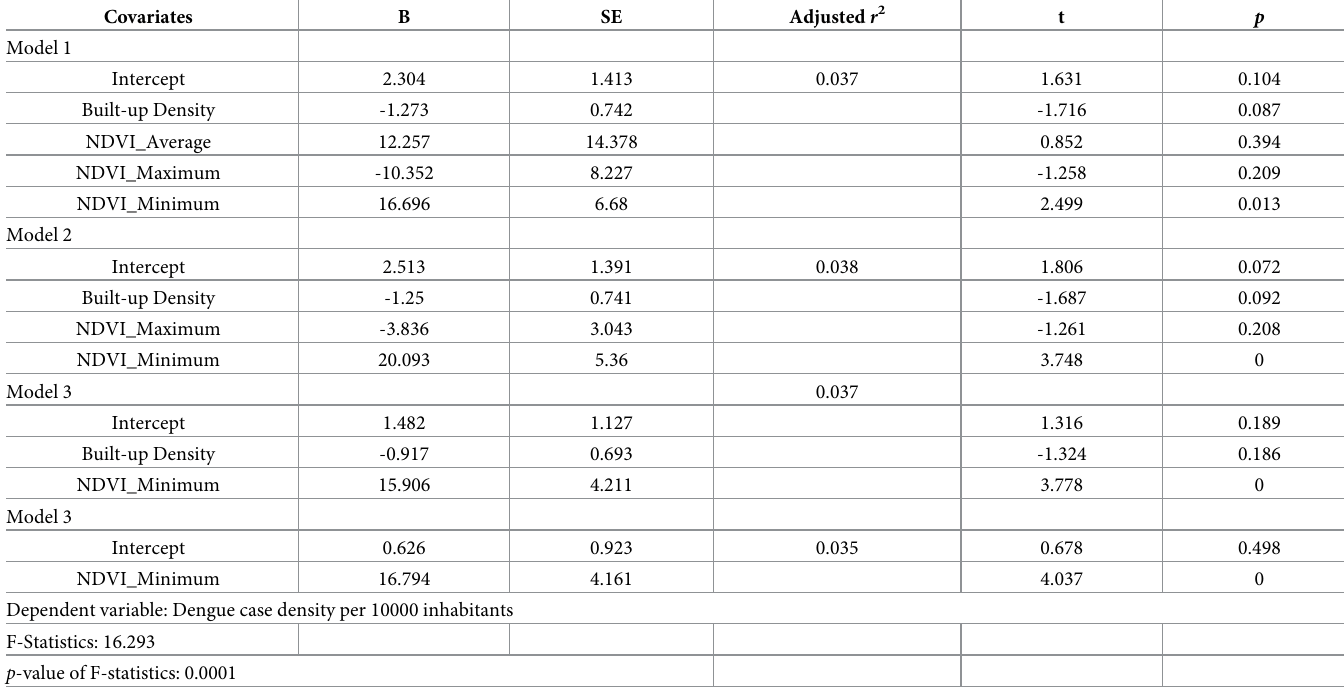
Table 3. Hierarchical multiple regression analysis with backward elimination of landscape variables on dengue incidence in Bhopal city. Covariates B